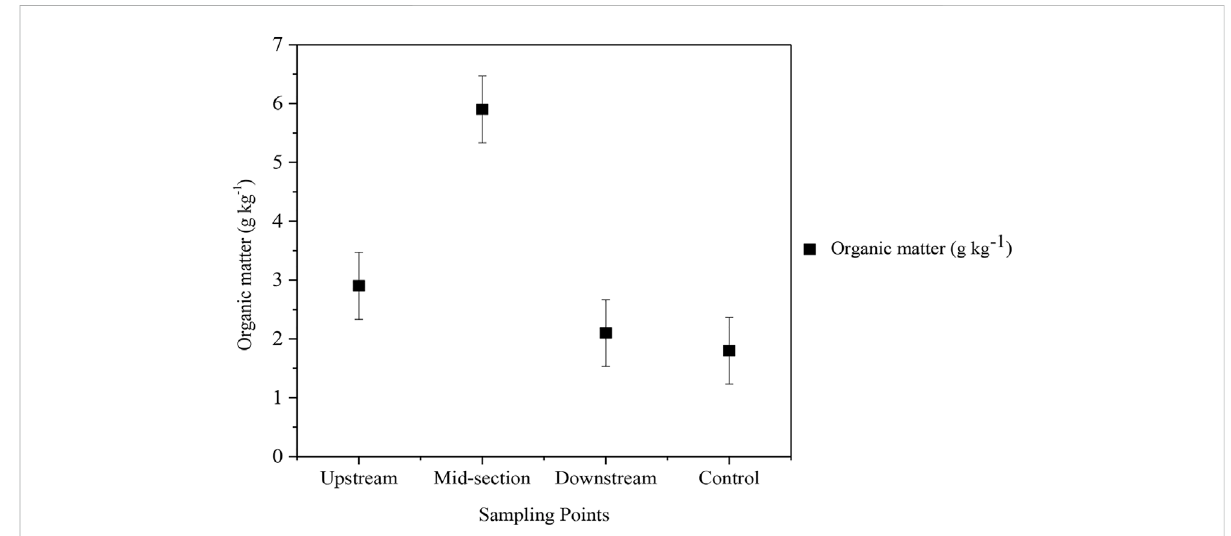
FIGURE 2 Organic matter content of soils along sampling points of a toposequence.